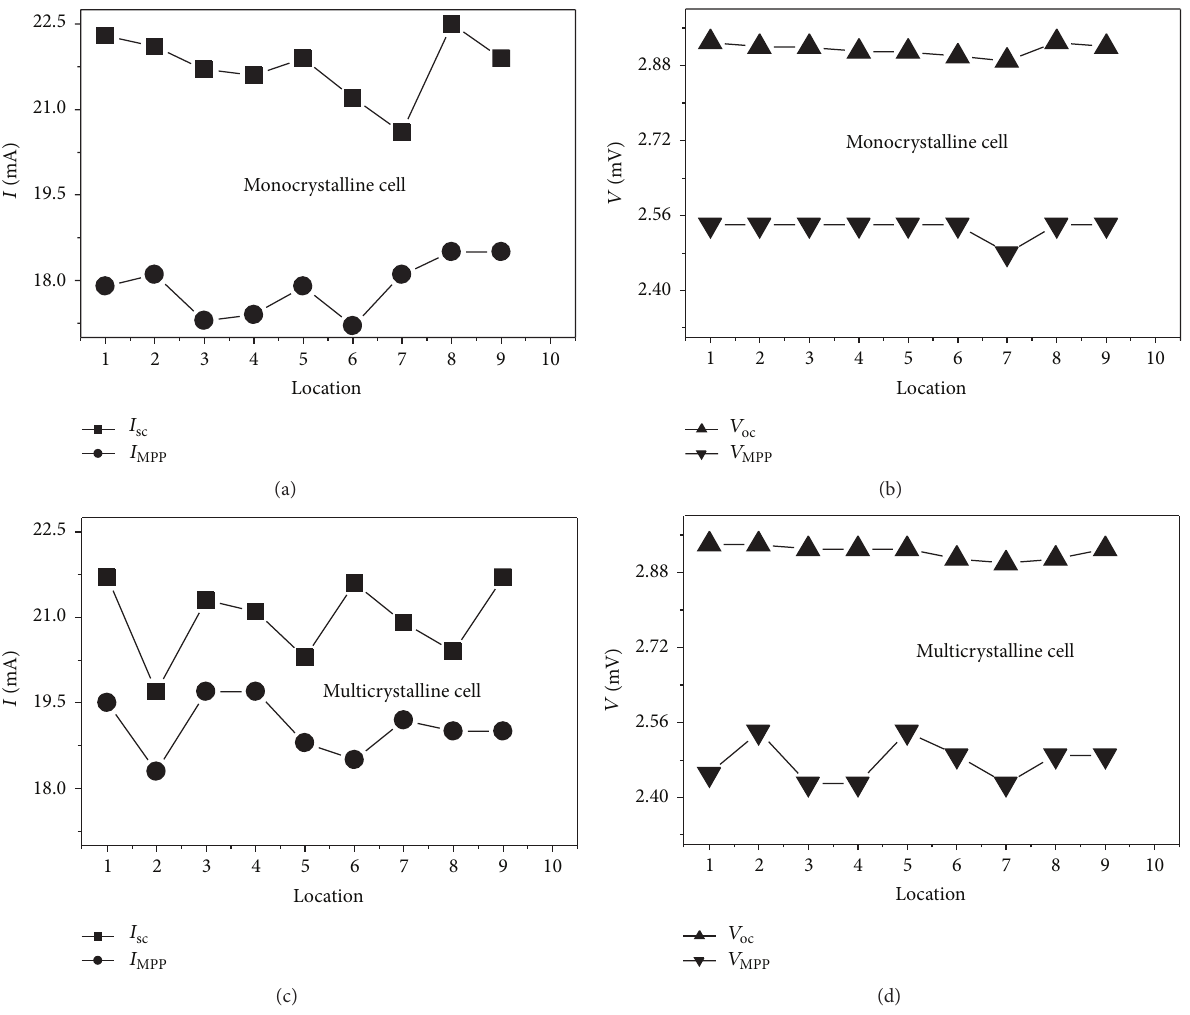
Figure 2: 𝐼 , 𝐼 MPP , 𝑉 , and 𝑉 MPP of monocrystalline ((a) and (b)) and multicrystalline ((c) and (d)) silicon solar cells against nine square sc oc shelter